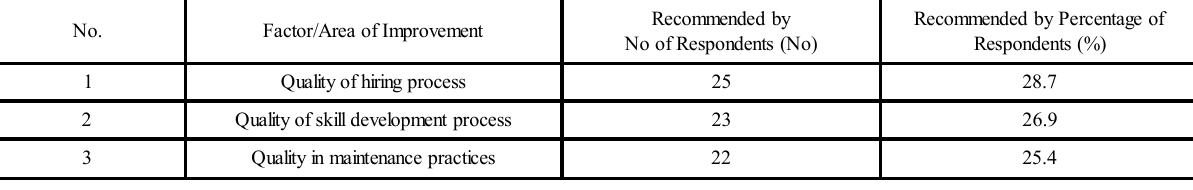
TABLE 6. QUALITY ENHANCEMENT